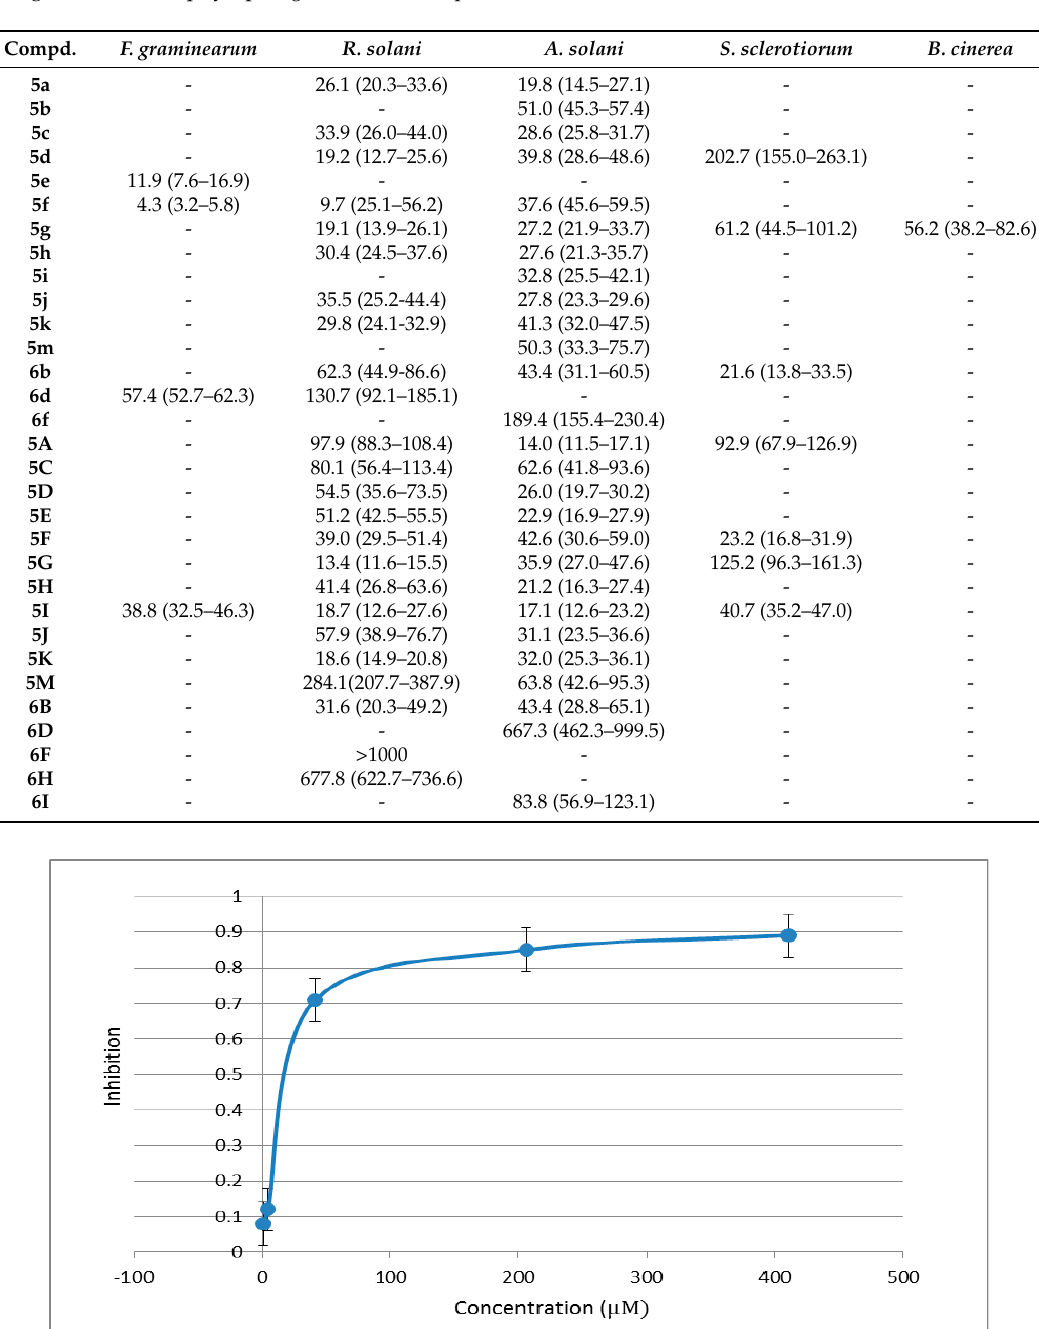
Figure 1. Inhibition rates of 5a against A. solani at different concentrations.